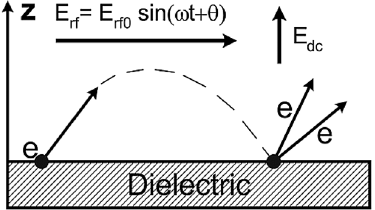
FIG. 1. Schematic of a multipactor on dielectric in parallel rf and normal dc